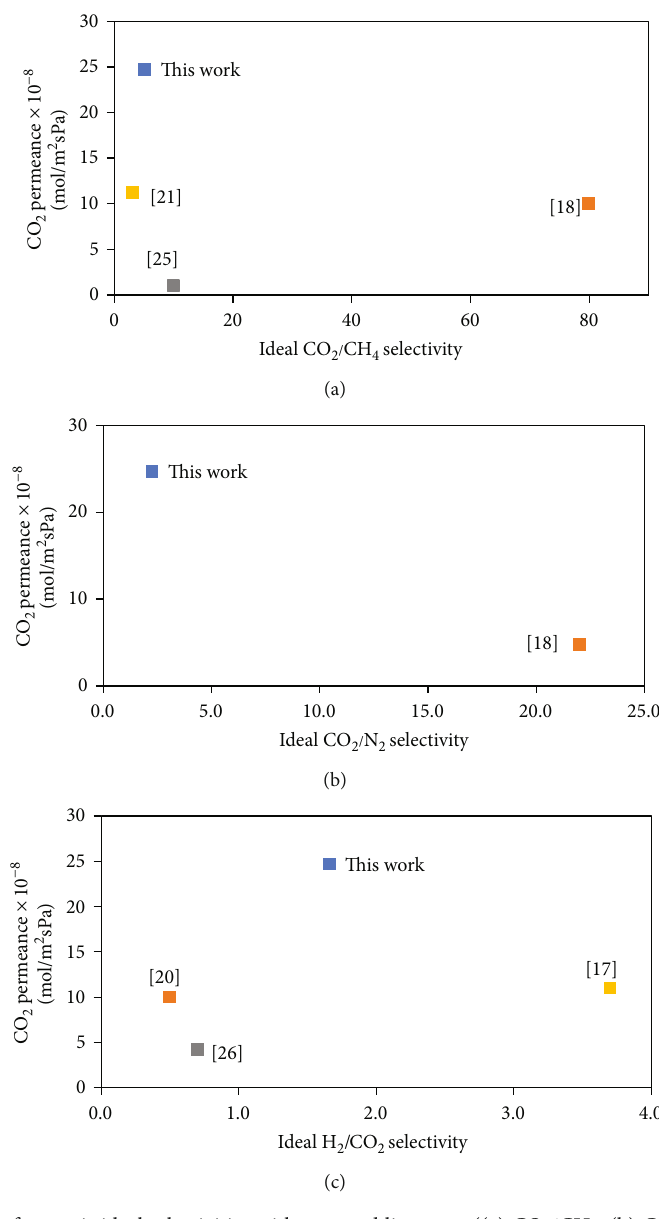
/CH , (b) CO /N , and (c) H 2 4 2 2